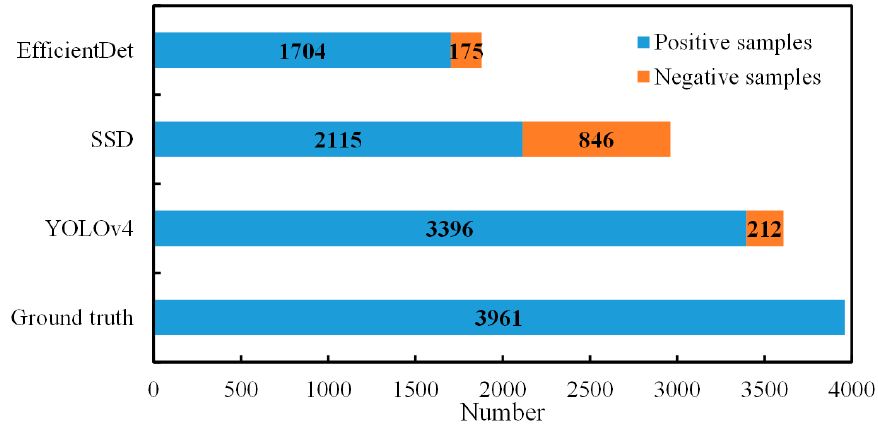
Figure 7. Comparison of the number of sorghum heads detected by different deep learning